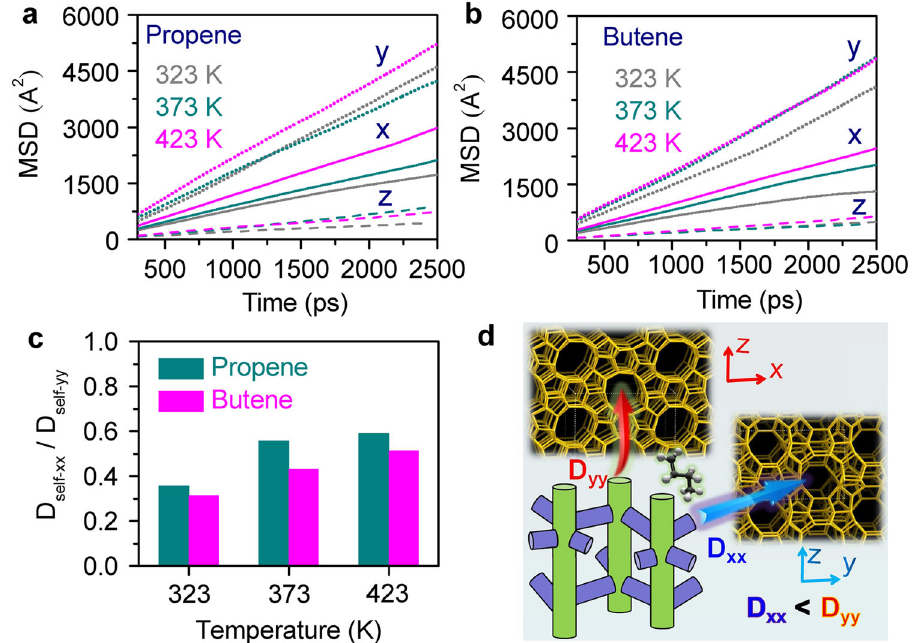
Fig. 6 Molecular dynamics simulations on the diffusion of propene and 1-butene molecules in MFI-structured zeolite. a MSDs of propene diffusion in different directions at different temperatures. b MSDs of 1-butene diffusion in different directions at different temperatures. c The ratio of self-diffusion coef fi cient in x - and y -directions. d Schematic view of ole fi n molecules diffusion along x - and y -directions of MFI-type zeolites. The anisotropic components MSD xx , MSD yy , and MSD zz curves were calculated by three individual samples, and the average MSD, D self- xx , and D self- yy are reported in this propene and 1-butene along the straight channel ( b -direction) are faster than that along the sinusoidal channels ( a - and c - directions). The diffusion coef fi cients along x - and y -directions ( D self- xx and D self- yy ) were then obtained from the slopes of these curves at different temperature (Eqs. 10 and 11 described in the “ Methods ” section), as listed in Supplementary Tables 4 and 5.